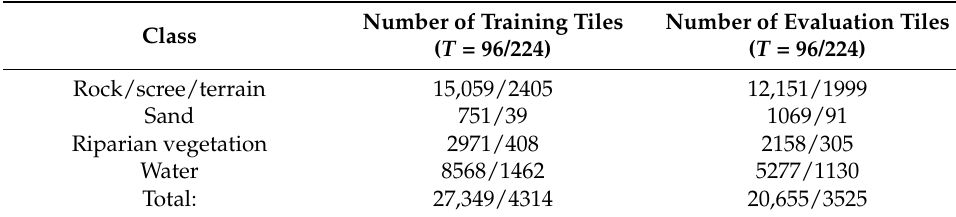
Table A3. Classes and number of tiles used for the Grand Canyon dataset.